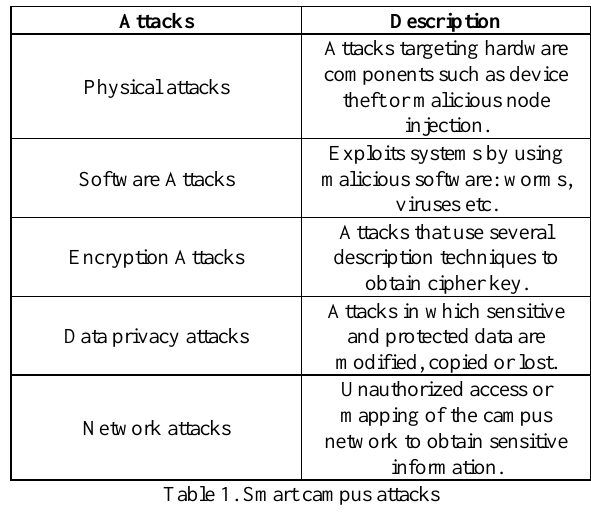
Figure 4. Account hijacking attack